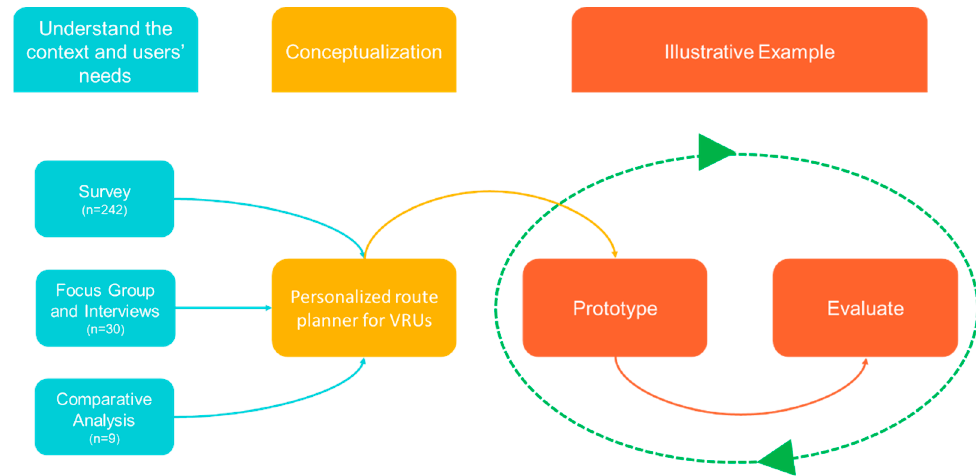
Figure 1. Methodological approach followed to develop the proposed route planner concept.